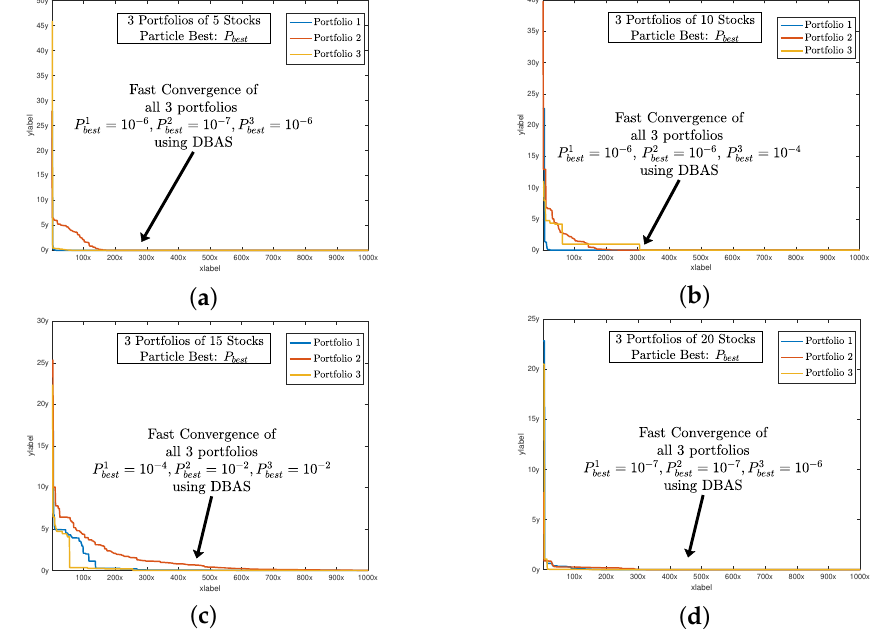
Figure 6. The sharp and fast convergence of DBAS particles P best toward their respective minimas while selecting an optimal configuration of their portfolios. Since we are dealing with three portfolios, we can see the three convergence profiles. ( a ) shows the global convergence profile of all algorithms. Likewise, ( b ) shows the convergence of BAS, PSO, and GA. And finally, ( c , d ) shows the convergence of 15 and 20 stocks of all three algorithms